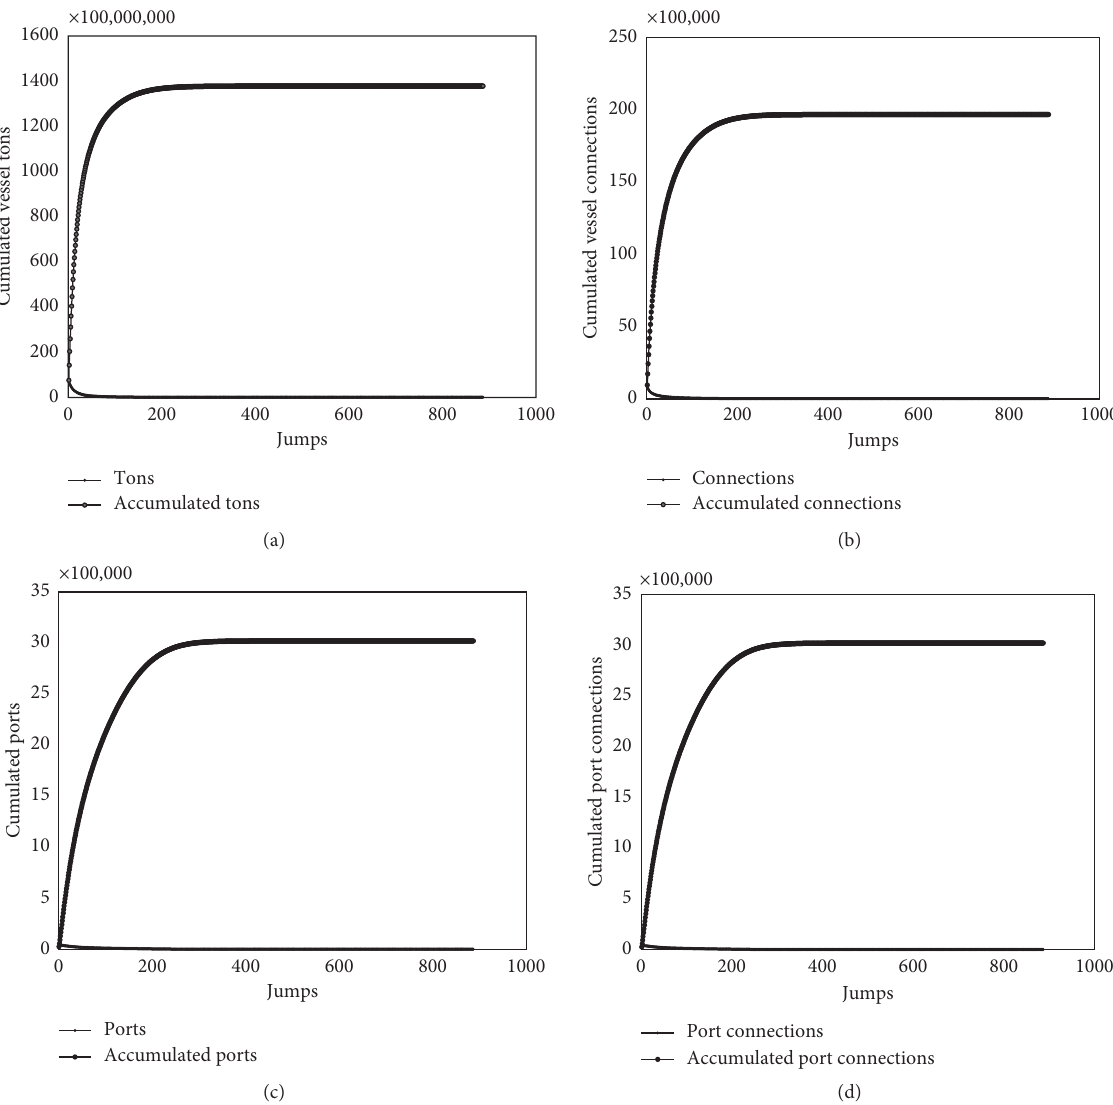
F seq | N io | F visit | jumps ≤ n . (b) jumps ≤ n . (c) jumps ≤ n . (d) jumps ≤ n .